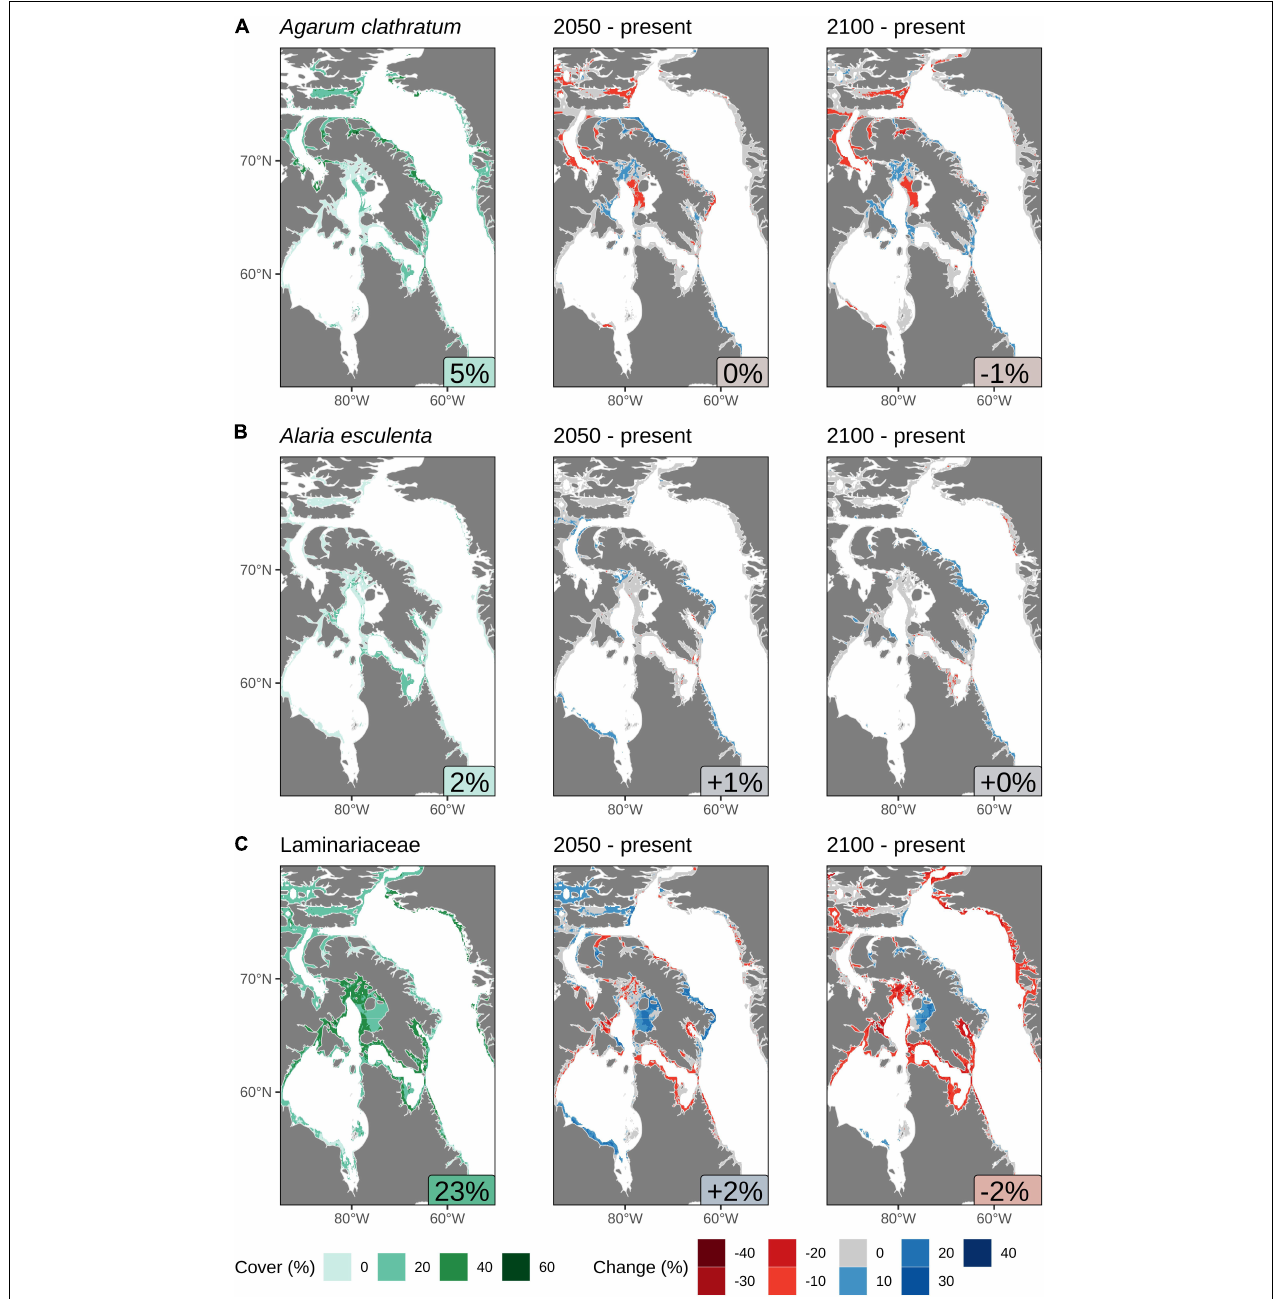
FIGURE 5 | Predicted cover (%) calculated in regions of suitable habitat using the results from the Random Forest model in the Eastern Canadian Arctic: (A) Agarum clathratum , (B) Alaria esculenta , and (C) Laminariaceae spp. The text labels in the bottom right of the panels in the left column show the average % cover in suitable habitat areas. The text column in the center and right columns show the average change in the % cover for that projected year. Note that these changes are not large due to much of the suitable habitat having a projected change in cover of 0%. All values shown are based on calculations of an assumed depth limit of 30 m, but for clarity, pixels are shown with a depth limit of 50 m or if they are within 15 km of